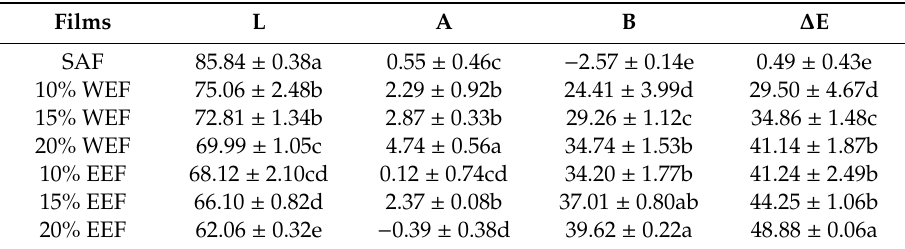
Figure 4. Physical appearances of the different films. Table 2. Color parameters of the di ff erent